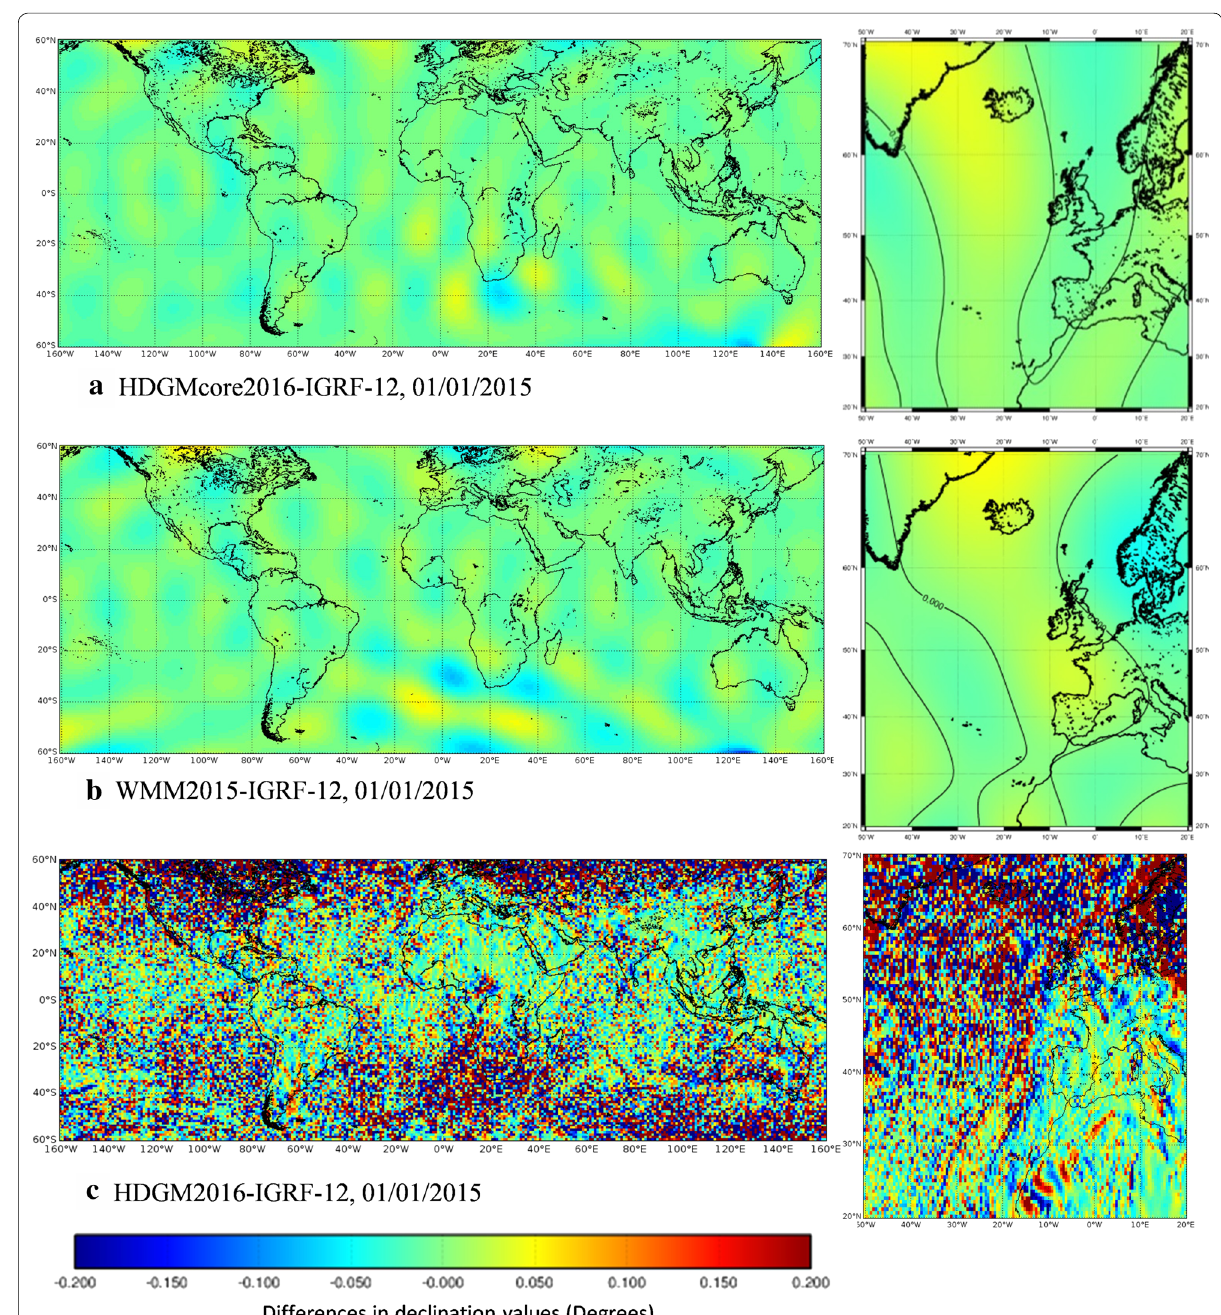
Fig. 5 Maps of differences in declination values estimated from HDGM2016core ( a ), WMM2015 ( b ), HDGM2016 ( c ) and IGRF‑12 (reference) models at a global scale reduced by 30° in latitude and 20° in longitude (left, grid spacing: 1°) and for the NEAWM area (right, grid spacing: